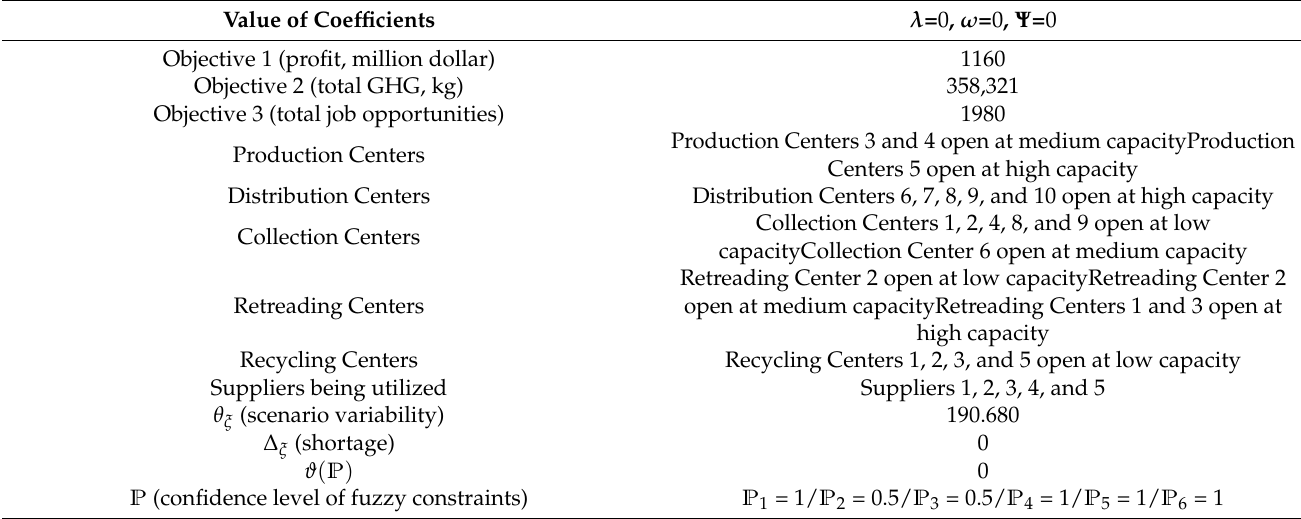
Table 9. Summary of optimum result (demand increase by 20% and considering opening an additional production